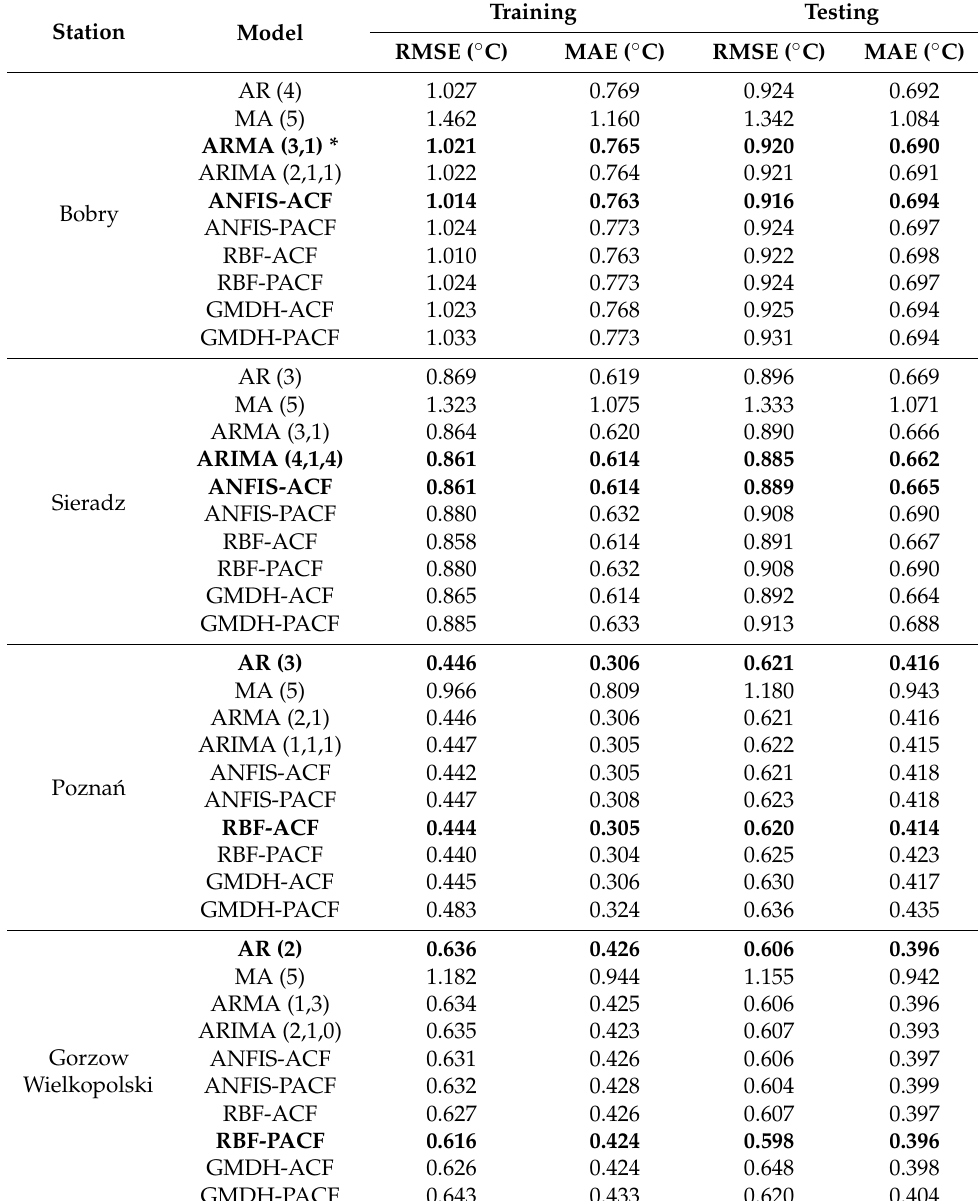
Table 2. Evaluating the implemented models for TRW